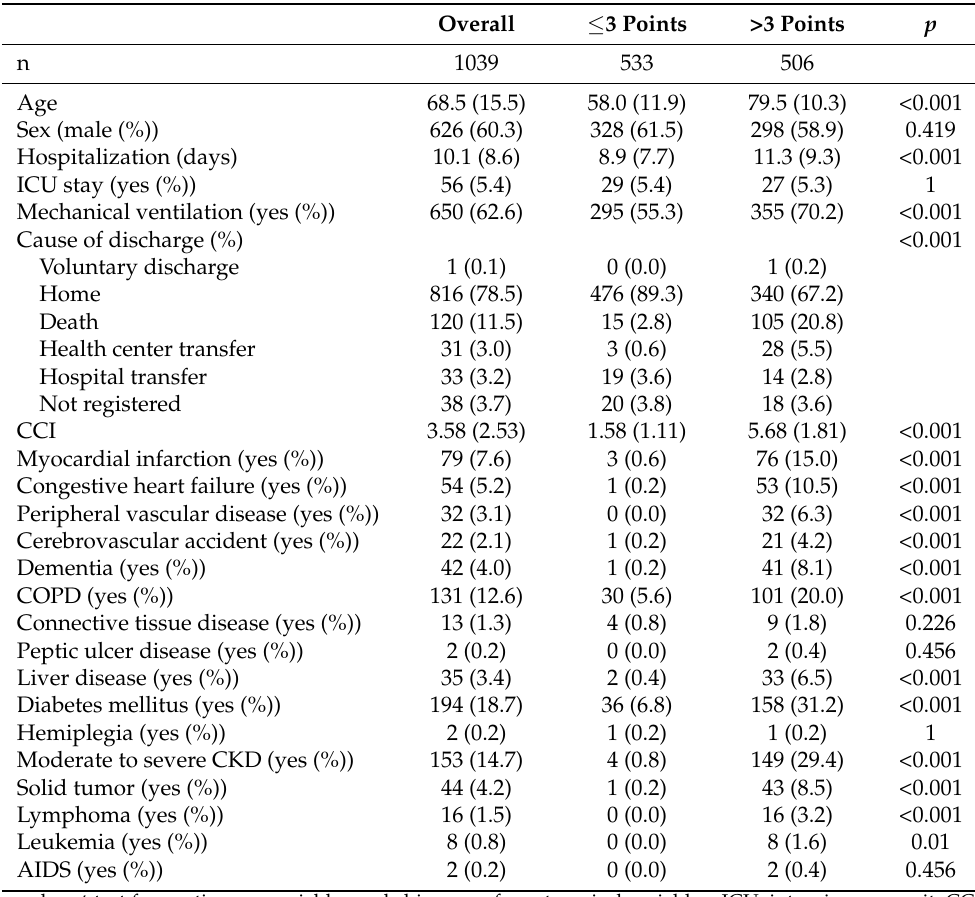
Table 1. Baseline and outcome characteristics of COVID-19 patients from DATA SAVE LIVES categorized by the Charlson comorbidity